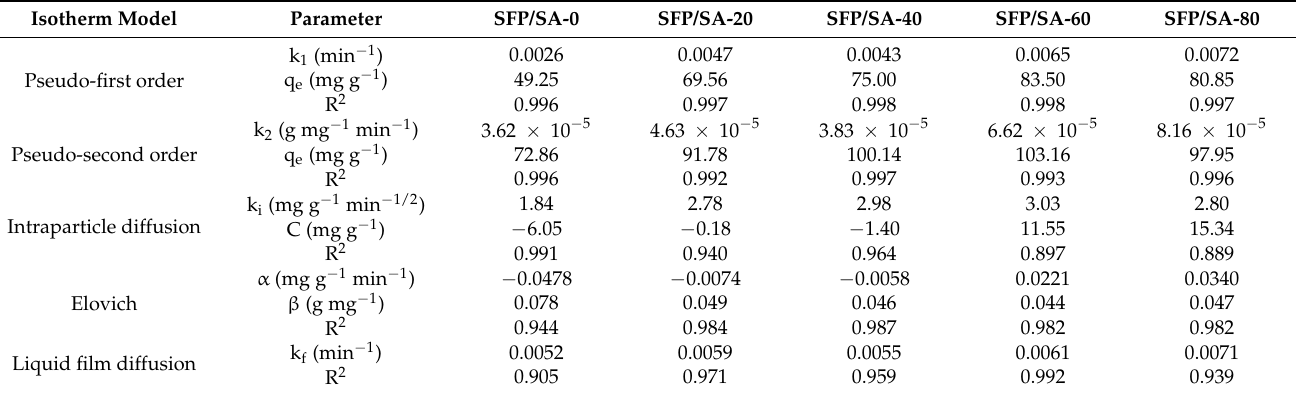
Table 2. Adsorption kinetic parameters for CV onto